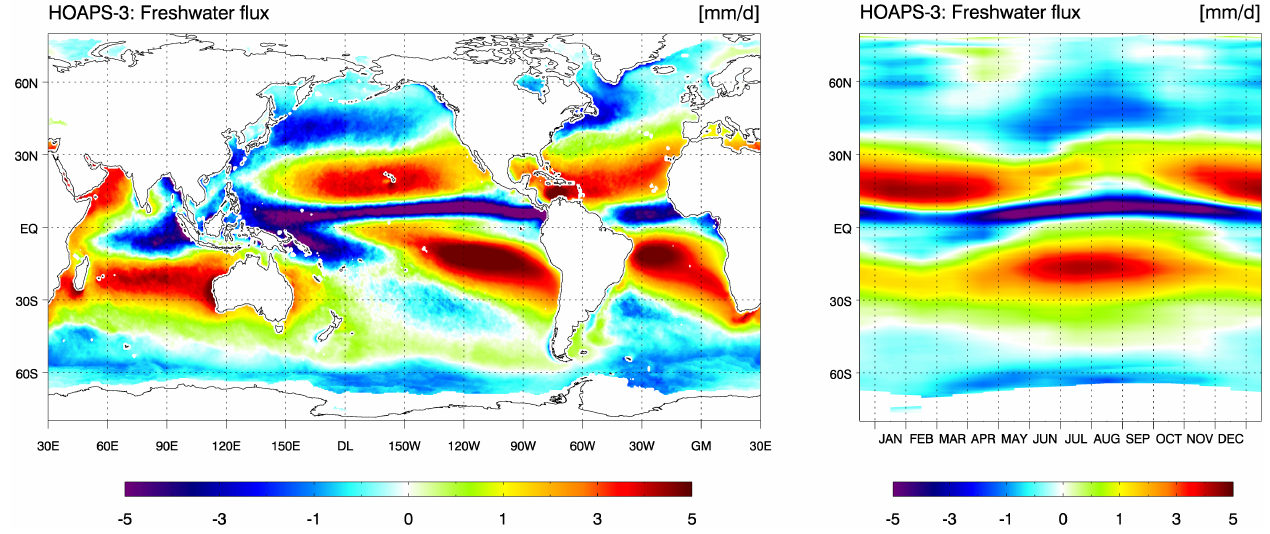
Figure 16. Climatological mean field (left) and zonal mean annual cycle (right) of the HOAPS-3 freshwater flux for the years 1988 to